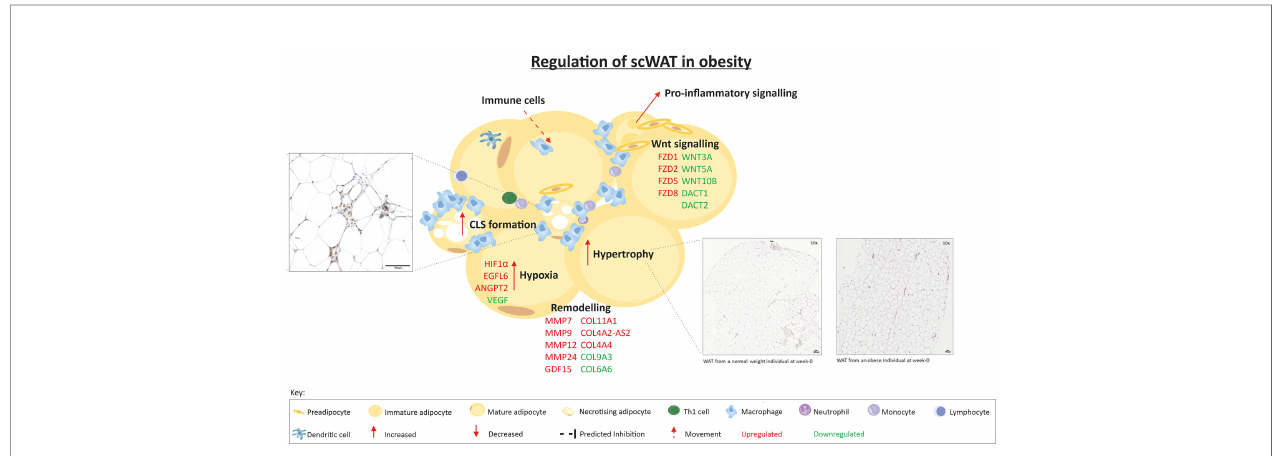
FIGURE 8 | The regulation of scWAT in obesity in which metabolic complications are yet to manifest. Indication of upregulation or downregulation of mRNA expression is the expression in individuals living with obesity in comparison to that of normal weight individuals at